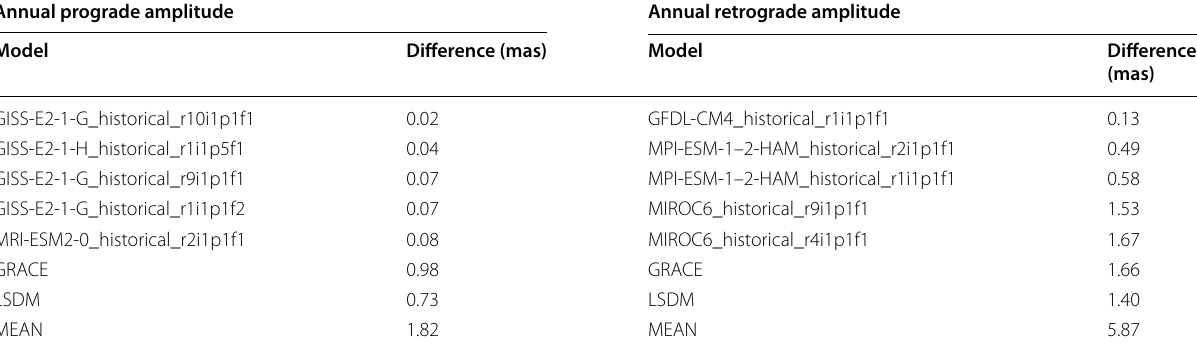
The results obtained from GRACE, LSDM, and MEAN model are also shown